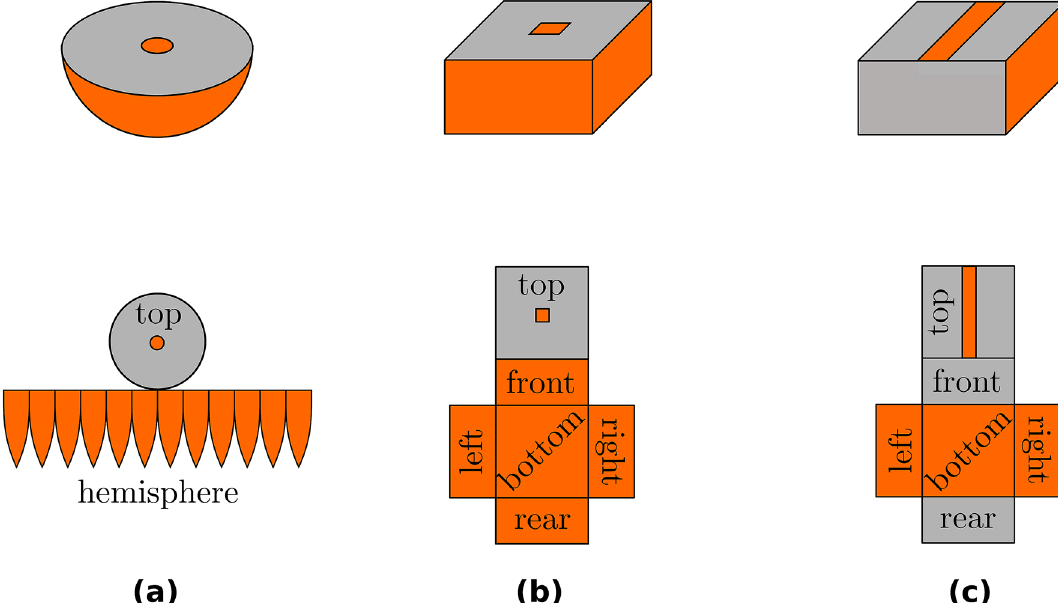
Figure 1. Pictorials (top) and net schemes (bottom) of ideal hemispheric detector ( a ), common quasi- hemispheric detector ( b ), and simplified quasi-hemispheric detector used in this study ( c ). Electrode areas are designated by orange